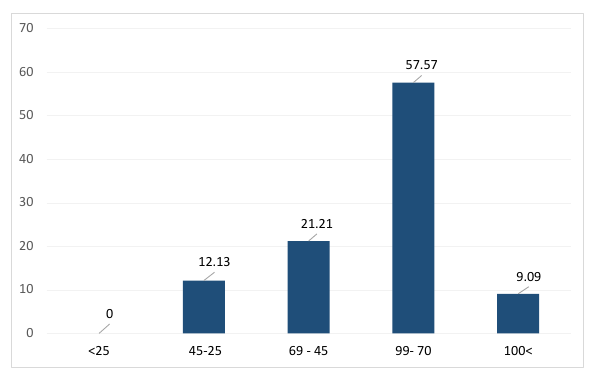
Figure 1. Serum lead level frequency percent for oral opium